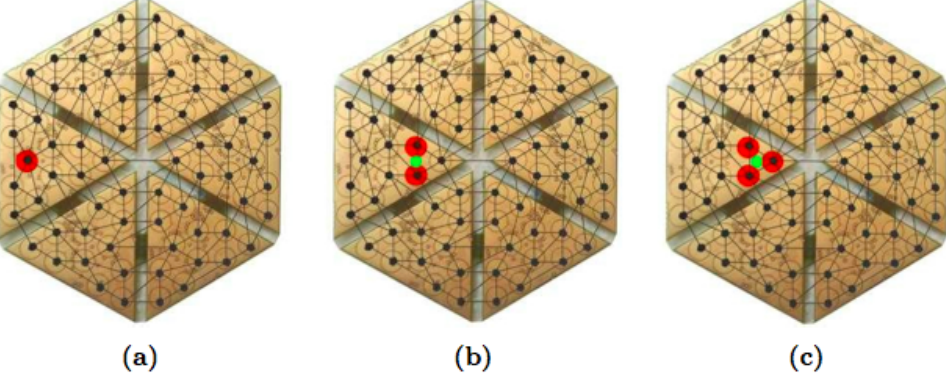
Figure 10. Load conditions in different trials: ( a ) indenter positioned over one taxel, between two taxels ( b ) and between three taxels ( c ).